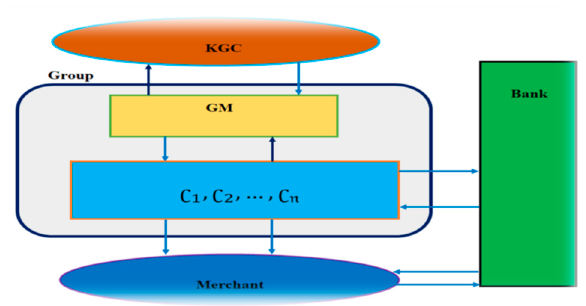
Figure 2. A model of the proposed electronic cash system (ECS).